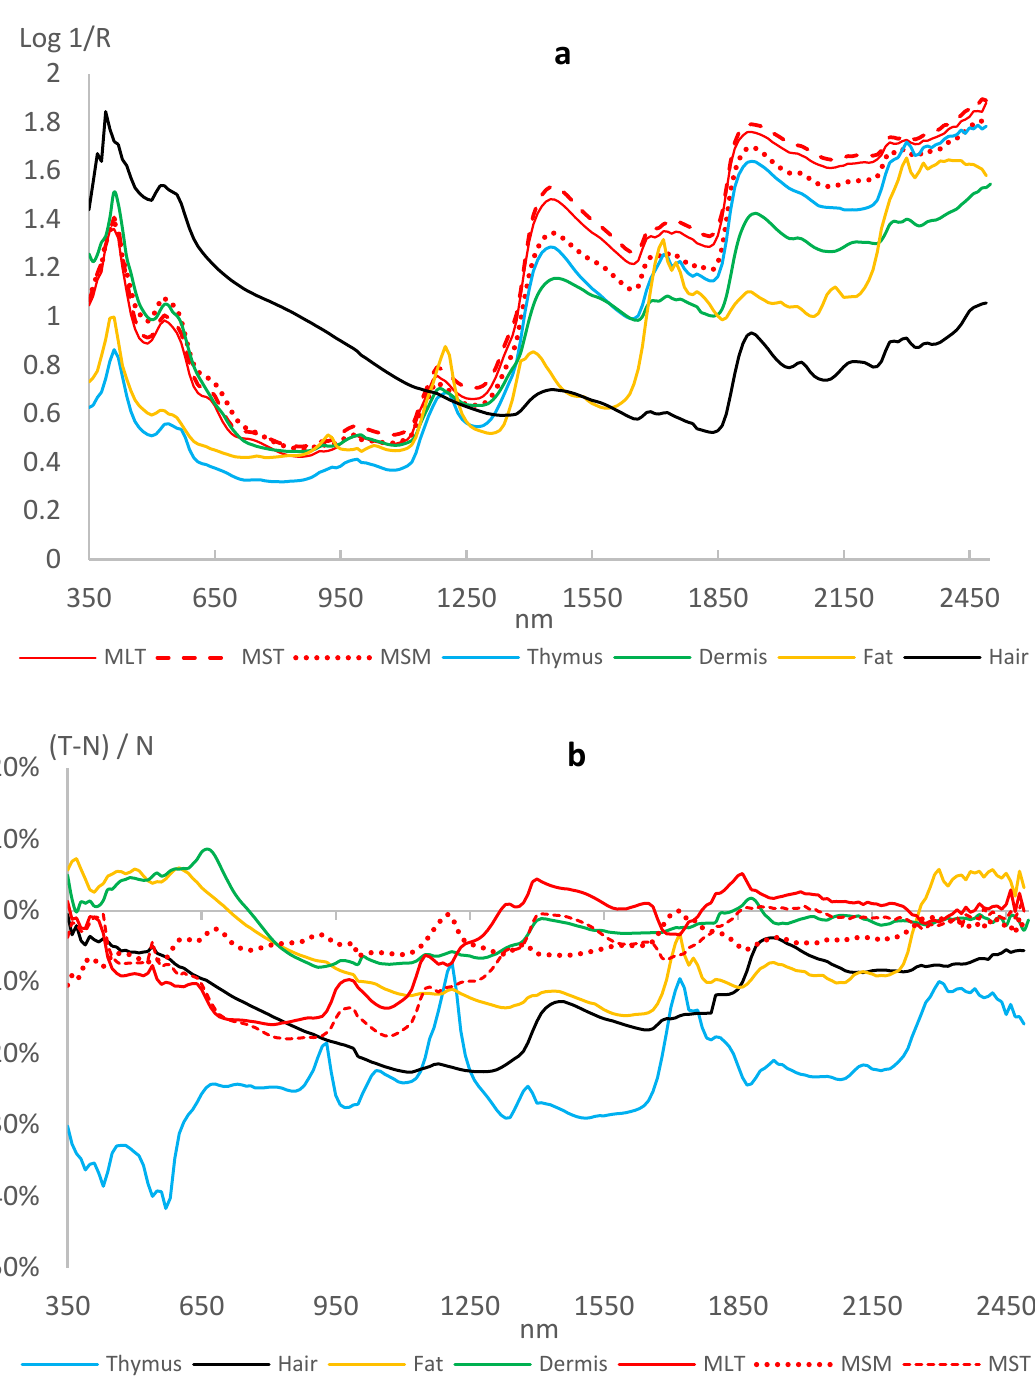
Figure 1. ( a ) Average of the full UV-Vis-NIR spectra of the seven tissues; ( b ) % of relative deviation in log(1/R) of the treated samples (T) with respect to the control ones (0 % line) for the UV-Vis-NIR spectra of the seven tissues; MLT = longissimus thoracis muscle; MST = semitendinosus muscle; MSM = sternomandibularis muscle; Fat; Thymus gland; Hair; Dermis .